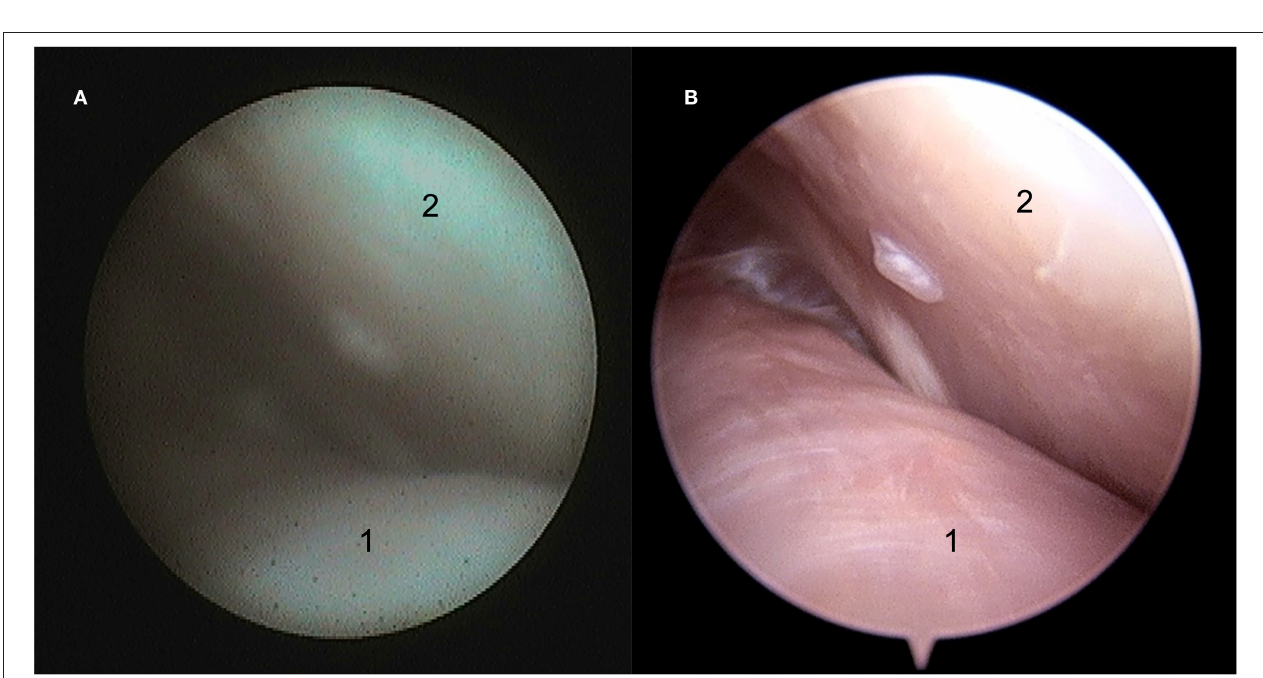
FIGURE 2 | Still arthroscopic image of the caudolateral aspect of the discotemporal joint (DTJ) using the NAS (A) and the STAN (B) . 1, intra-articular disc; 2, caudal aspect of the joint.